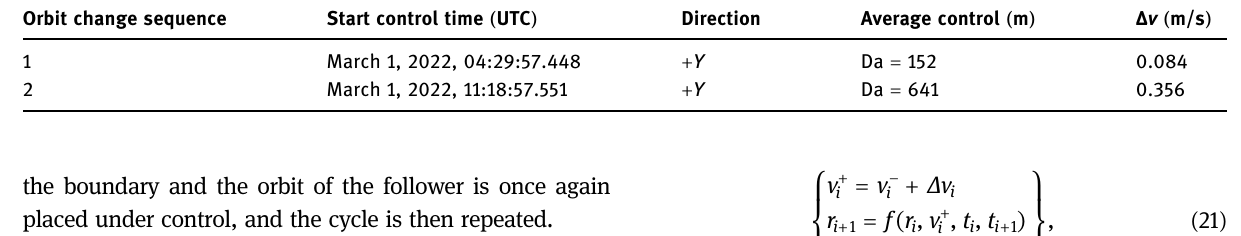
Orbit change sequence